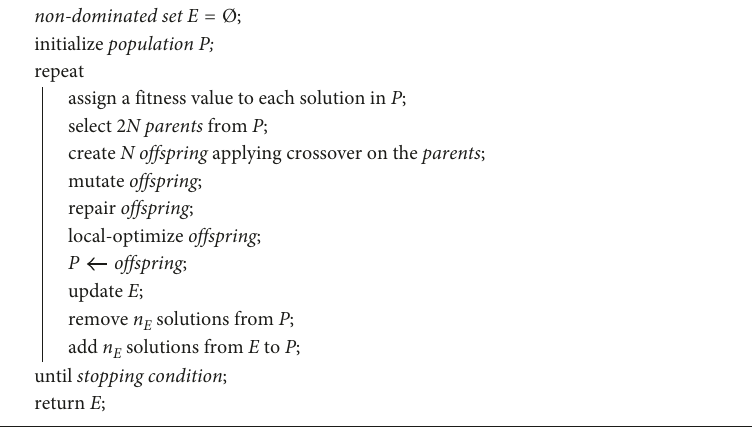
Figure 4: The framework of our hybrid multiobjective genetic